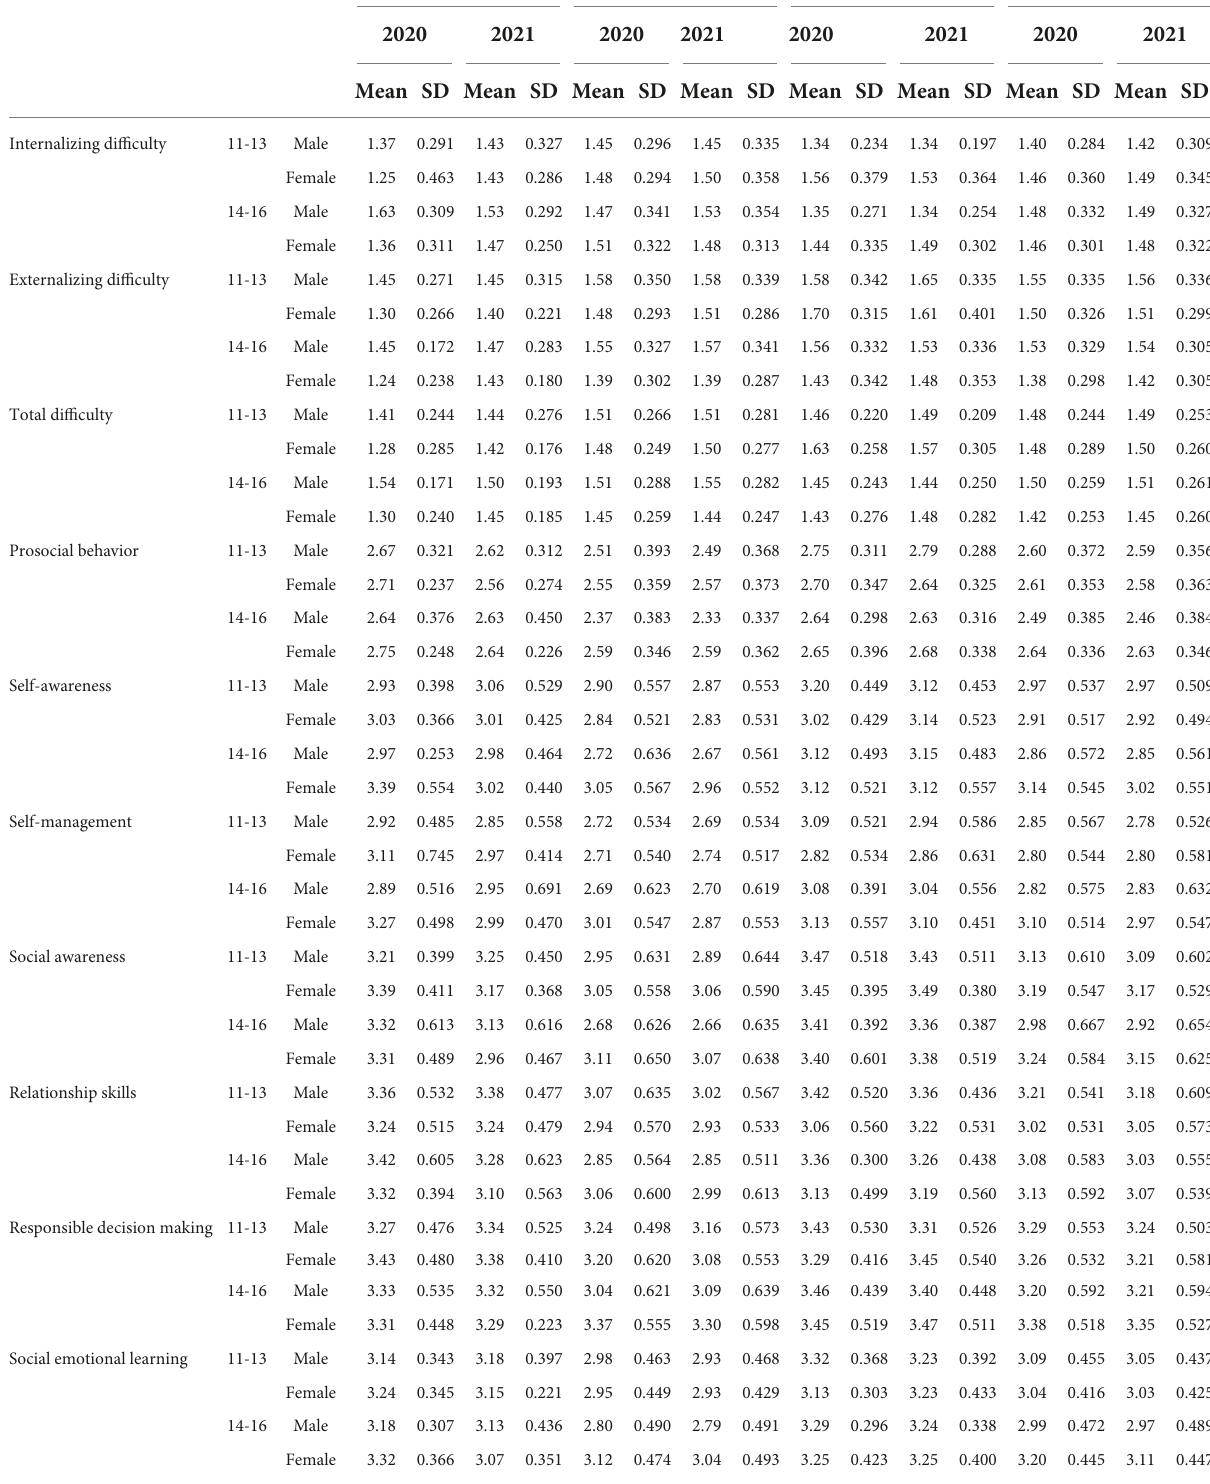
TABLE 6 Mean SDQ, SSIS-SEL, and CD-RISC-10 scores as reported by parents ( n = 512). Subscale Age